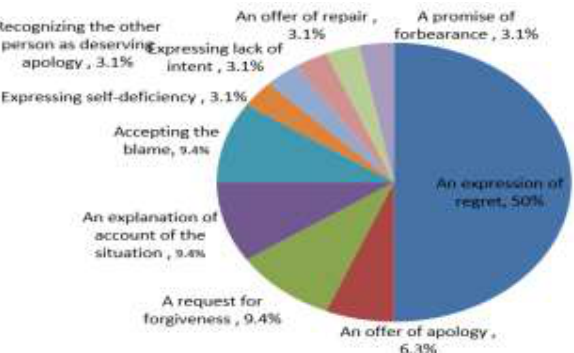
Figure 1. The Use of Apology Strategies by Characters in the